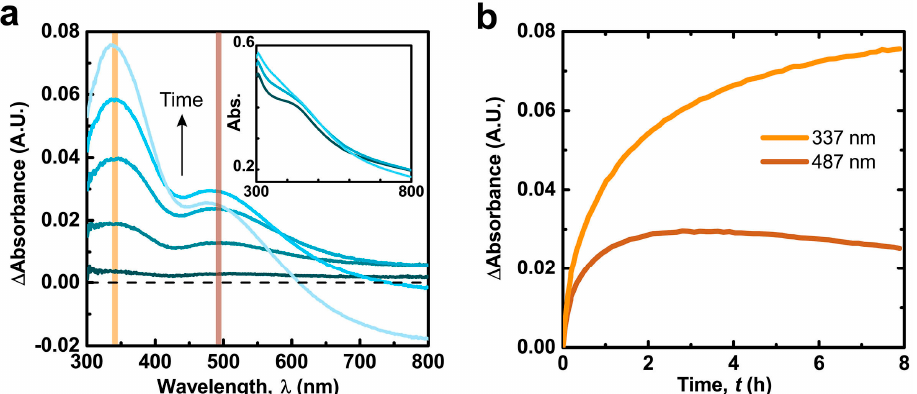
Figure 1. ( a ) Subtracted ultraviolet-visible (UV-Vis) spectra of polydopamine (PDA) film in 300 mM CaCl 2 , 50 mM tris(hydroxymethyl) aminomethane (Tris) buffer pH = 9.5. Inset: Original spectra; ( b ) Absorbance at the designated wavelengths over time (spectra recorded every 83 s).